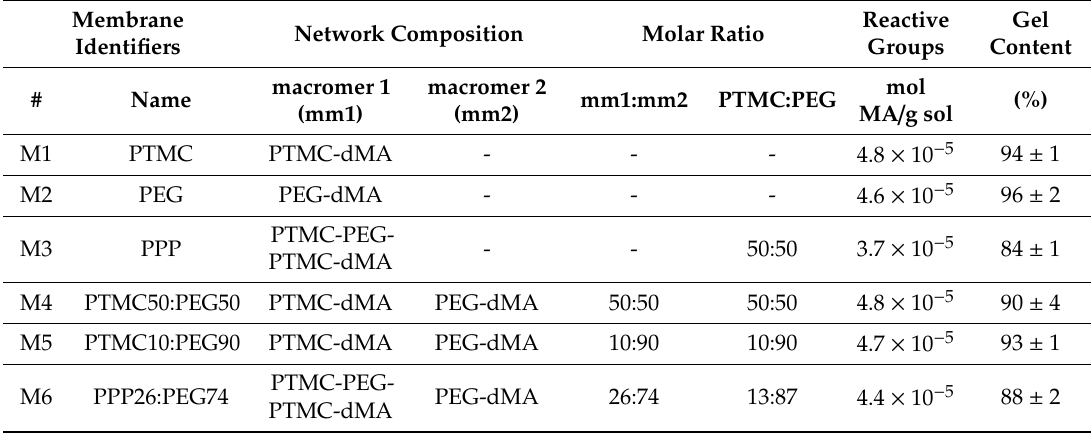
Table 2. Membrane composition. The gel content is the mean ± SEM for at least three networks. Membrane